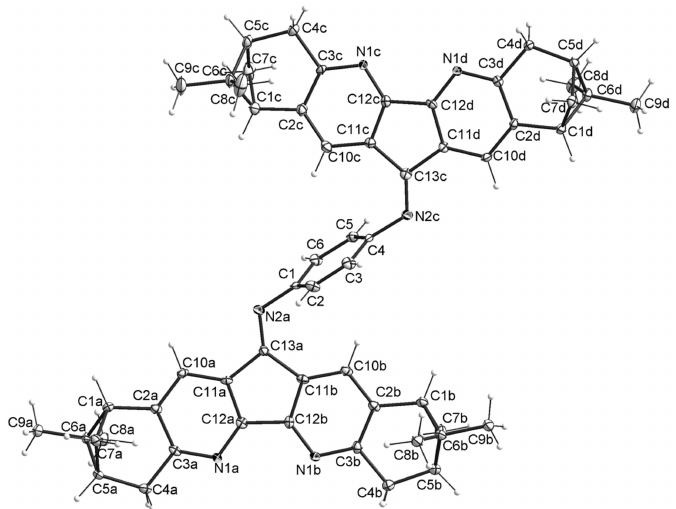
Figure 3. Thermal ellipsoid plot of 4 in the crystal structure showing 30% probability ellipsoids (the solvent molecules are not